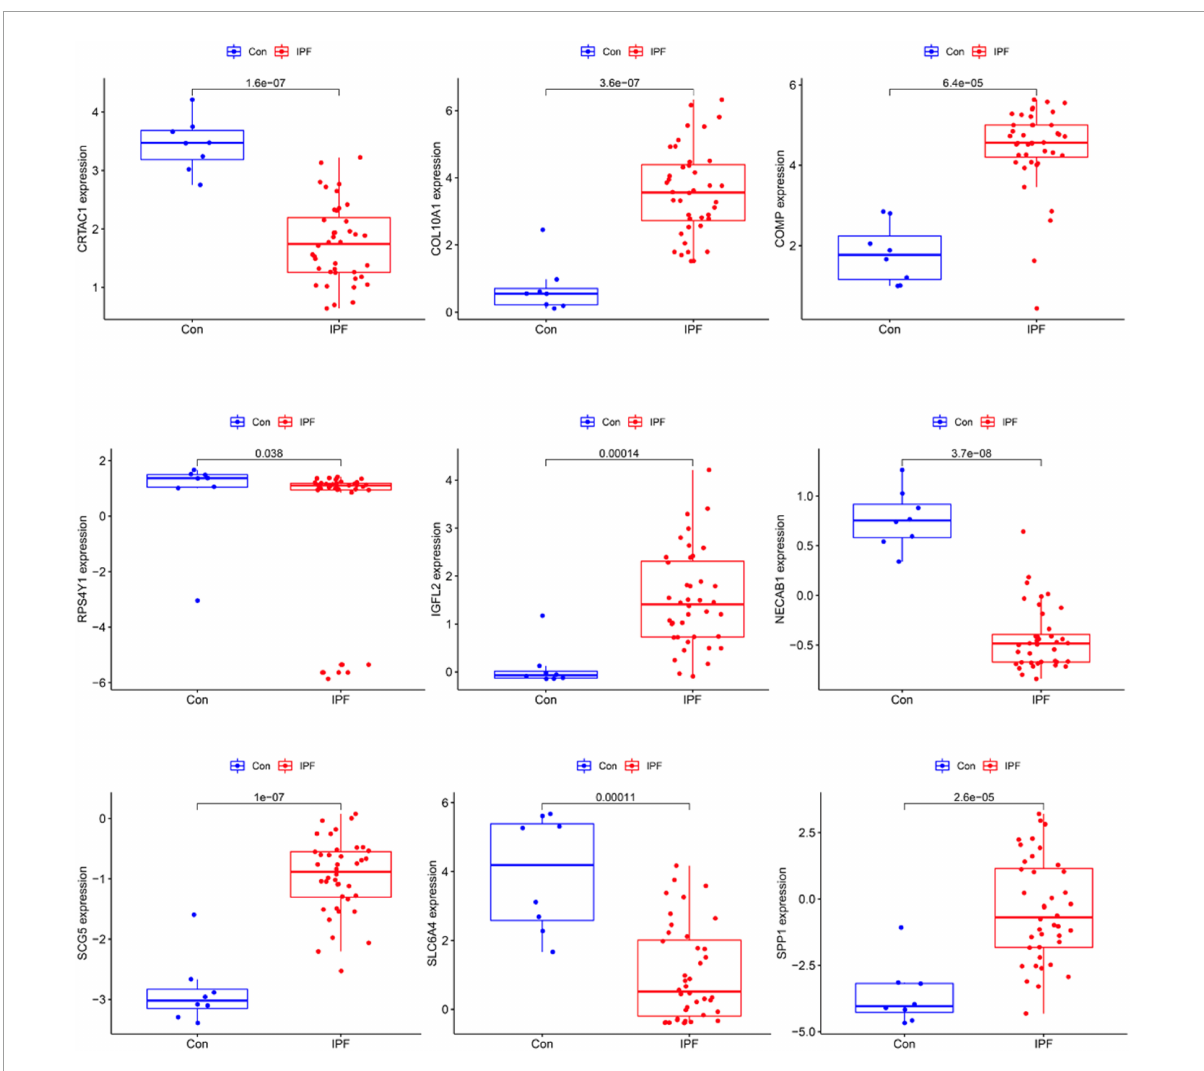
FIGURE9 Verification of the level of diagnostic biomarkers in the GSE53845 infomationset.